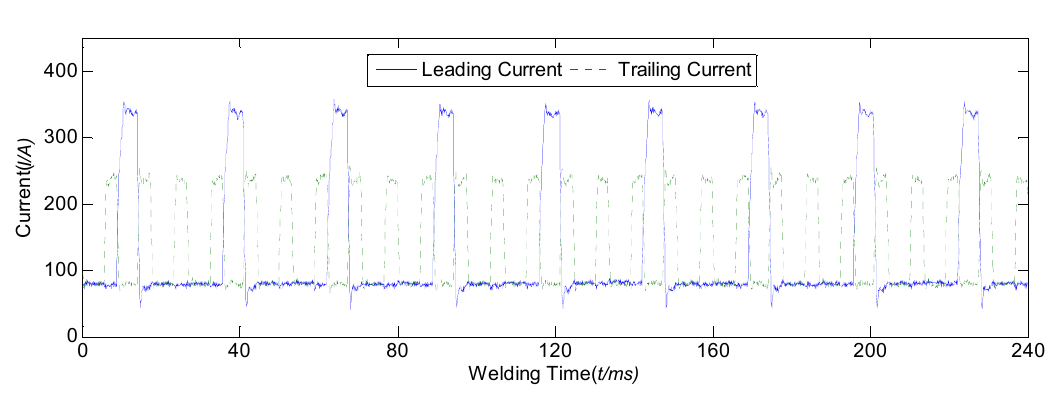
Figure 13. Pdf under the optimal parameters combination. According to Figures 6, 9 and 13 and corresponding analyses, the variation information of pdf can show the stability of welding process. If the welding current was unstable, the convex peak between currents in peak stage and base stage was gentle, while pdf value of the convex peak was relatively small, however, the pdf value between currents in peak stage and base stage was large.